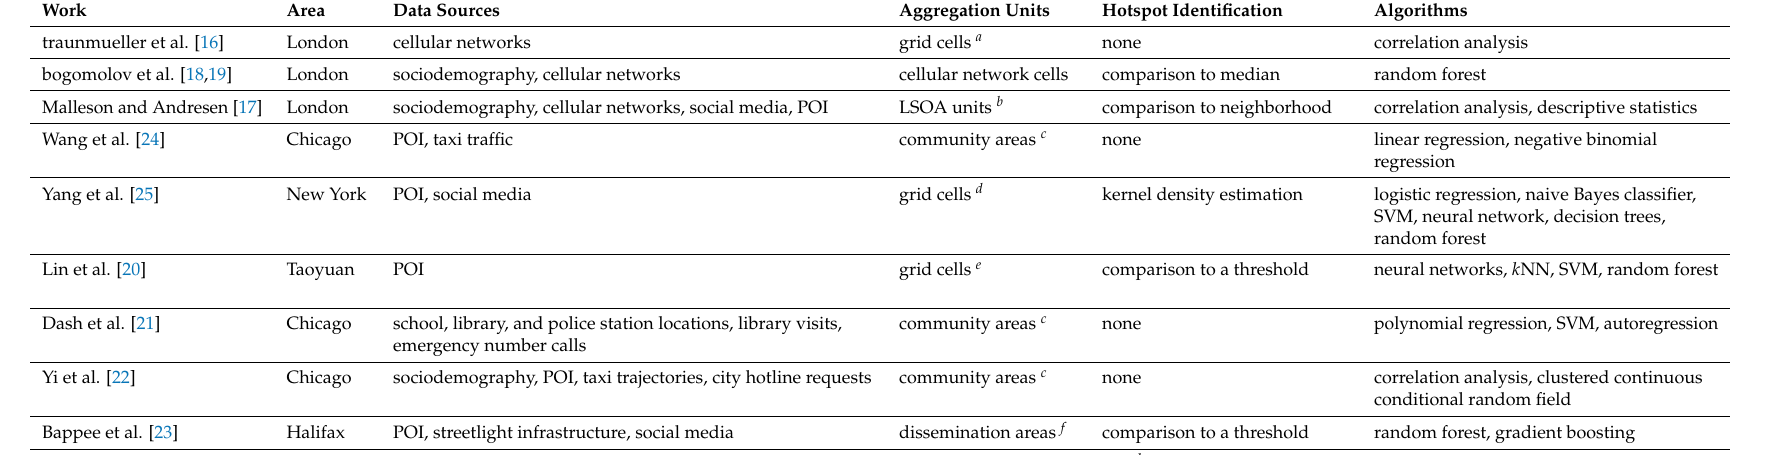
Table 1. Related